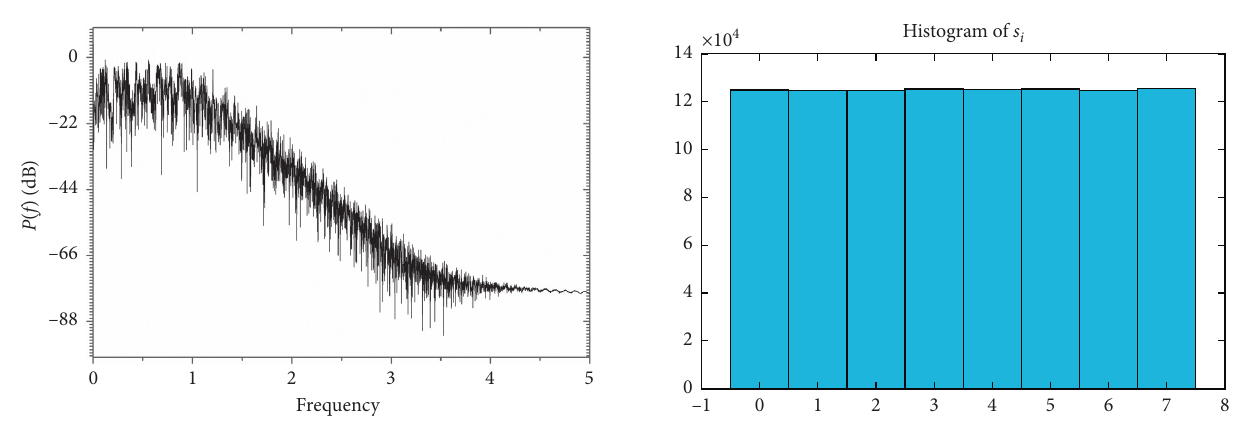
Figure 10: Product of the states for initial values ( x c � 1.4, and d � 0.85.